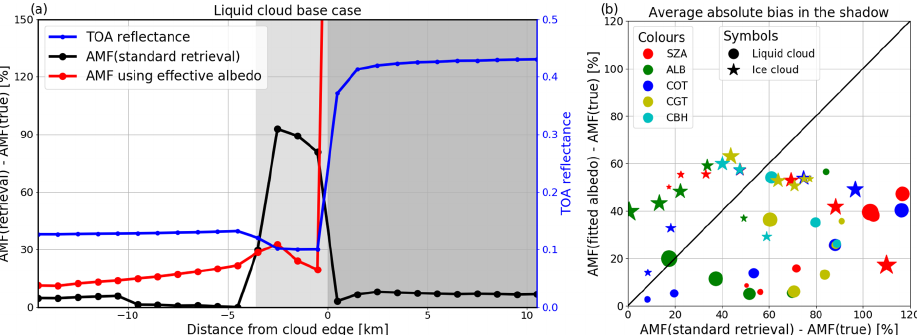
Figure 13. Similar to Fig. 11 but for the NO 2 AMF using the effective surface albedo. Notice that the x and y range in panel (b) is [ 0 , 120 ] instead of [ 0 , 240 ]